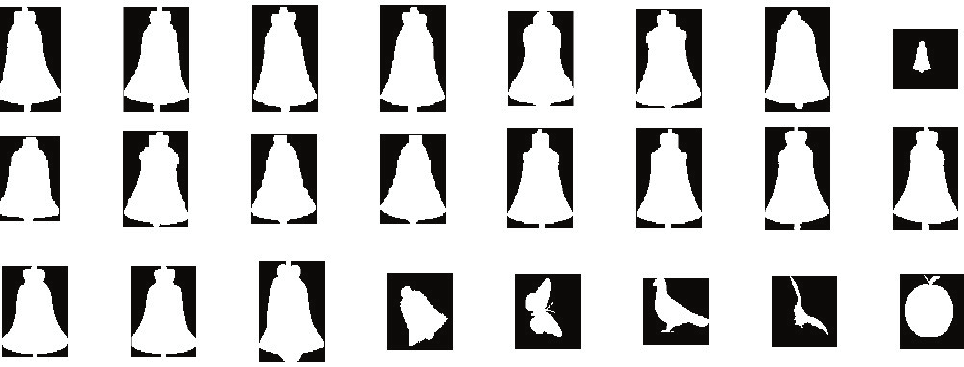
Fig. 5. The shape database for unusual shape detection.